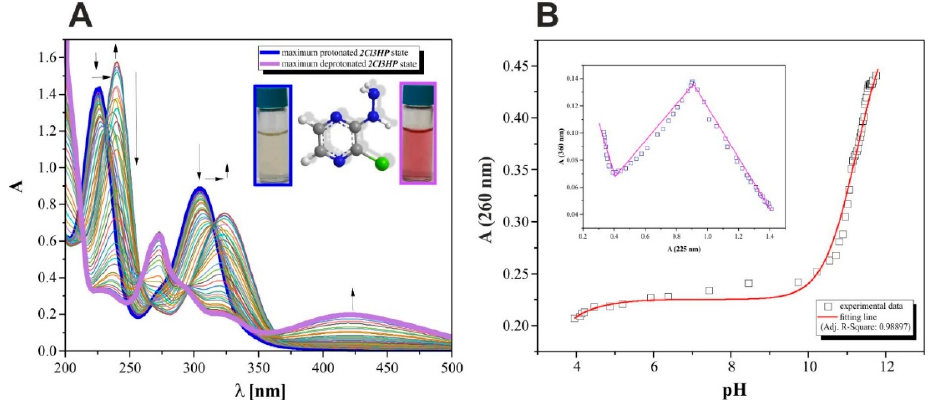
Figure 6. Spectrophotometric results: ( A ) set of UV spectral curves of 2Cl3HP (0.25 mM) sample acidified as a function of pH (3.88–11.80); ( B ) absorption at 260 nm vs. measured pH; experimental data were presented by squares; calculation results were included as red line; R 2 = 0.98897. The relationships between the absorbance wavelength of 260 nm and pH values were